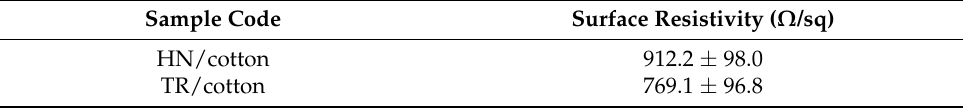
Table 4. Surface resistivity of CFDM 3D GR/PLA-based HN and TR on cotton